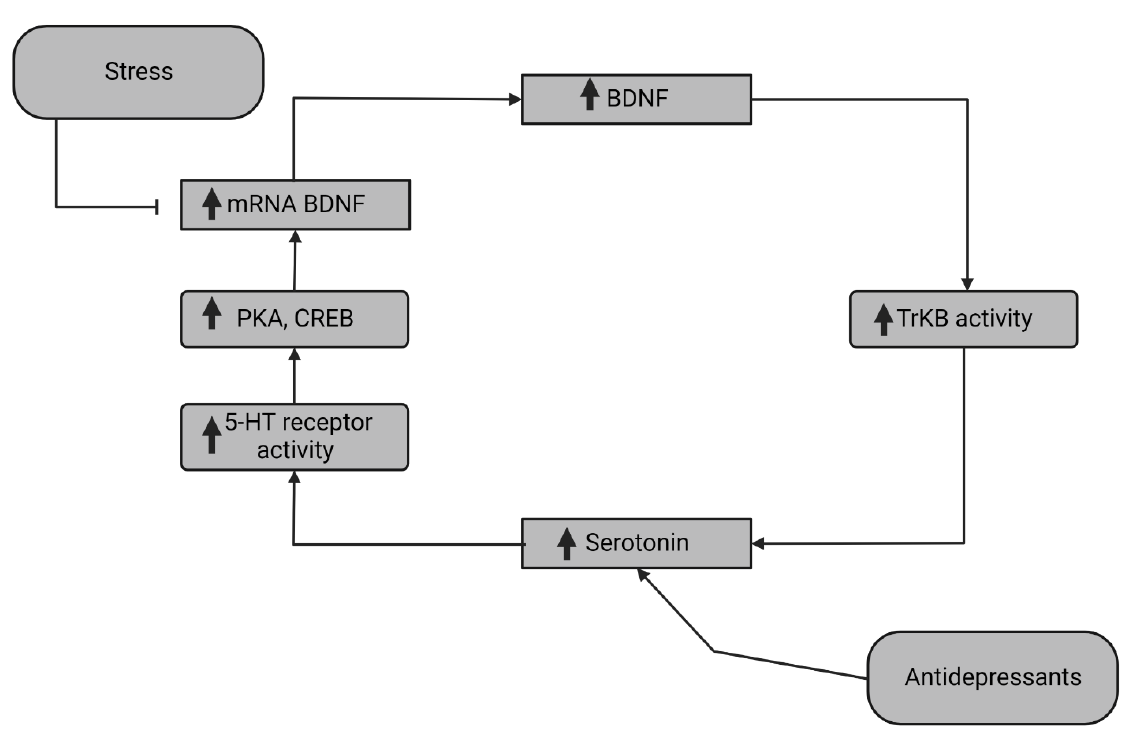
Figure 2. Mutual interactions between BDNF and serotonin. Antidepressants increase the level of serotonin, which accounts for higher 5-HT receptor activity. Activation of this receptor increases the cAMP level, which in turn induces the PKA/CREB signaling pathway and stimulates BDNF expression. Stress, on the other hand, hinders the production of this neurotrophin. 5-HT: serotonin; BDNF: brain-derived neurotrophic factor; CREB: cAMP response element-binding protein; mRNA: messenger RNA; PKA: protein kinase A; TrKb: tropomyosin related kinase.